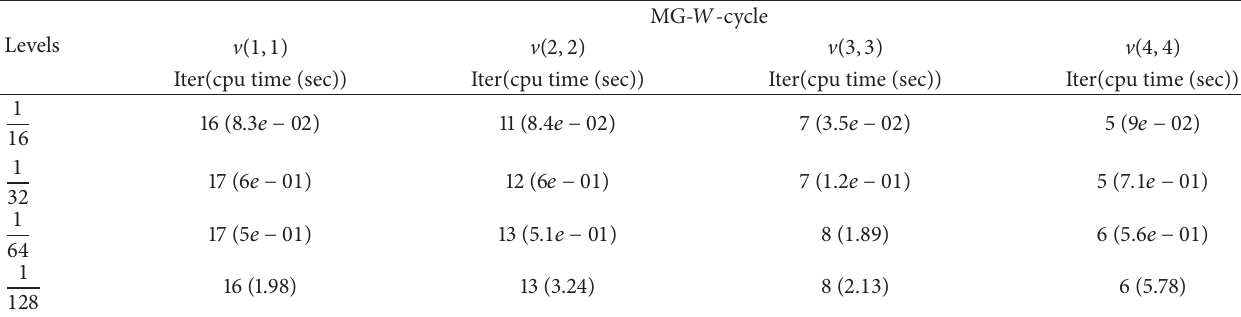
Table 3: Number of iterations and CPU time for Braess-Sarazin (2diag( 𝐴 ), V ( 1, 1 )) multigrid 𝑊 -cycle at different levels of refinement, tolerance = 10 −6